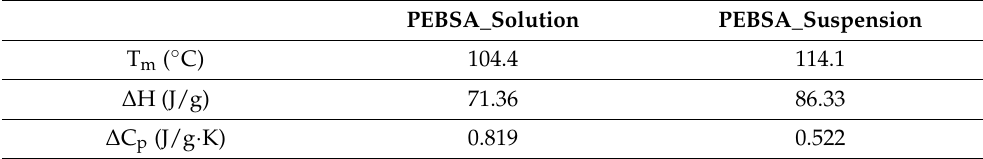
Table 3. Differential thermal